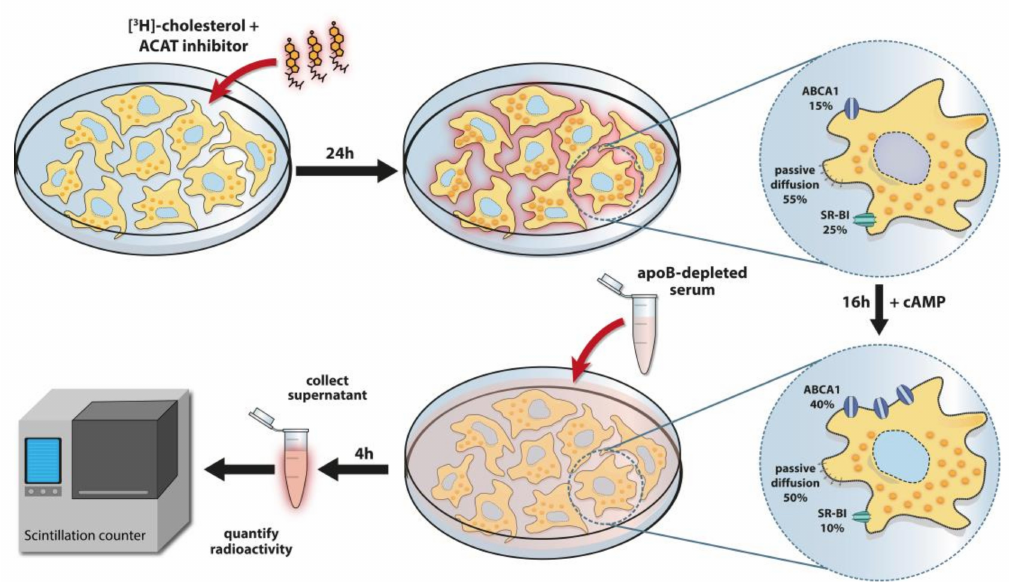
Figure 1. Principle of the cholesterol e ffl ux assay. J774 macrophages are cultivated in multiwell